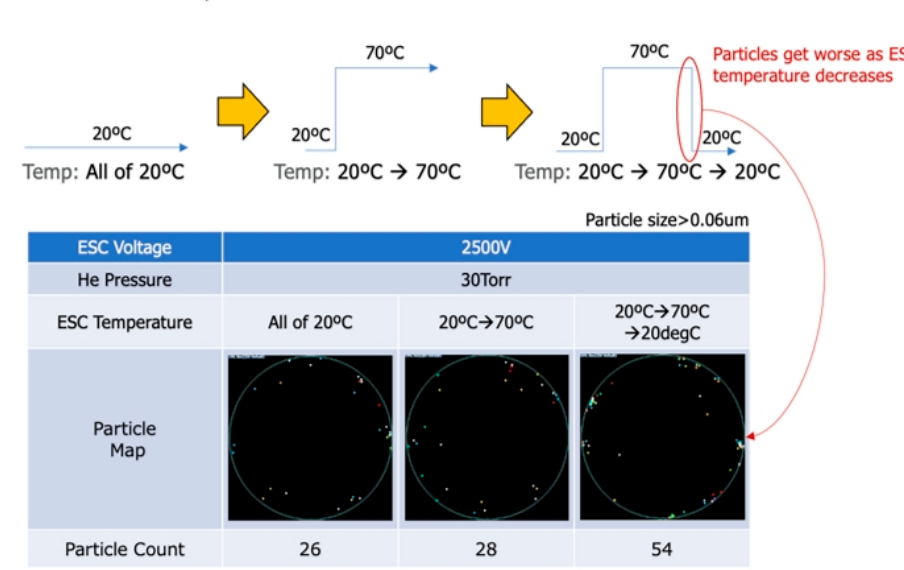
Figure 16. Particle deposition under increases and decreases in the temperature of the